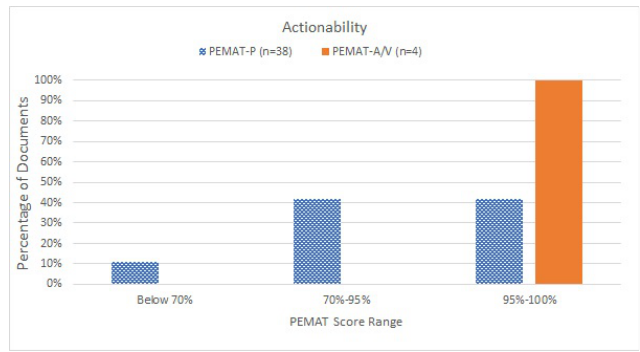
Figure 2 Distribution of materials upon actionability assessment using PEMAT. A score of 70% or above is considered highly actionable, and a score below 70% indicates poor understandability